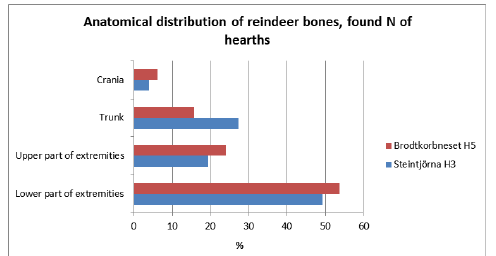
Figure 9. Anatomical distribution of faunal material found outside hearths H3 Steintjörna and H5 Brodt-